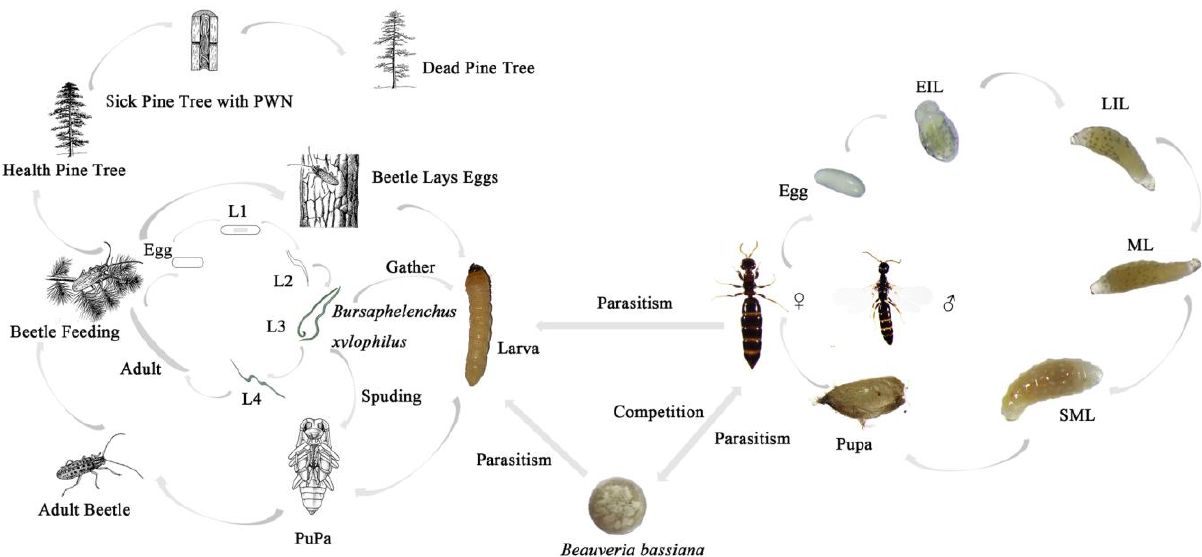
Figure A1. Interspecific relationships between the “ S. guani-B. bassiana-M. alternatus ”.